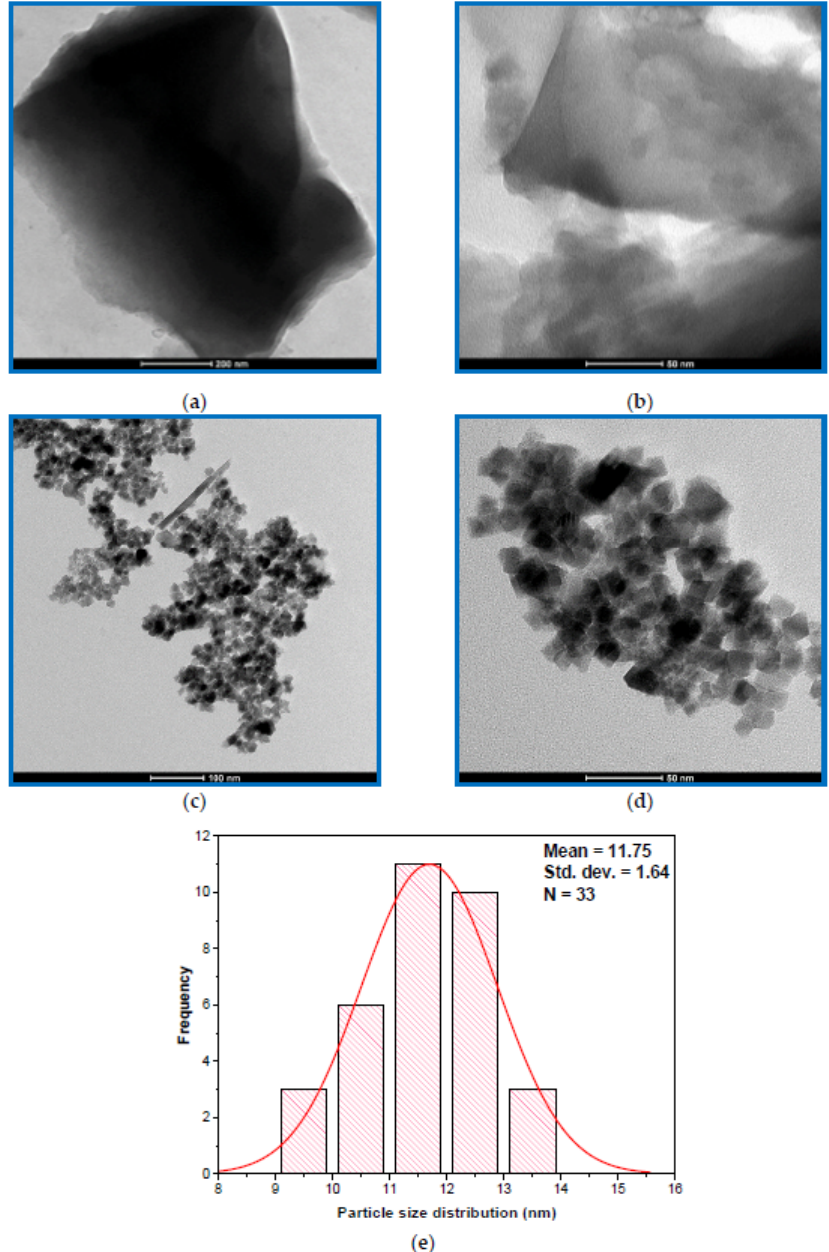
Figure 6. TEM images of the OSBC at two scales ( a ) 200 nm, ( b ) 50 nm and MAG-OSBC at ( c ) 100 nm, ( d ) 50 nm and ( e ) PSD results for the